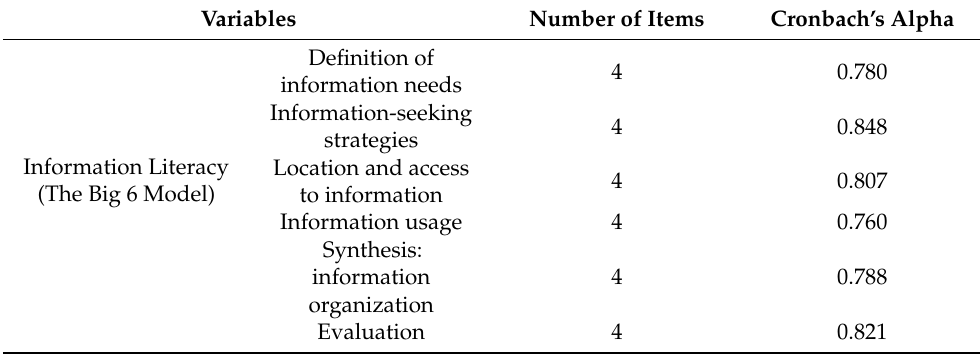
Table 1. Reliability analysis